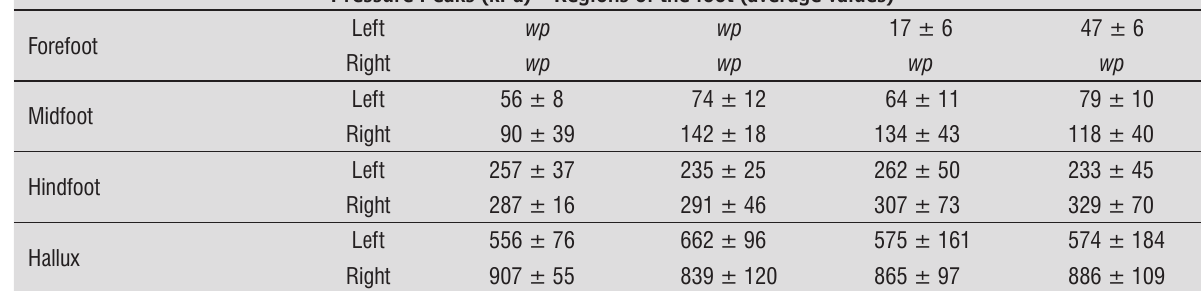
Note: PRE1(before intervention period-without TheraTogs ® ); PRE2 (before intervention period-with TheraTogs ® ); POST1 (after intervention period-without TheraTogs ® ) e POST2 (after intervention period-with TheraTogs ® ). wp =without pressure peaks.